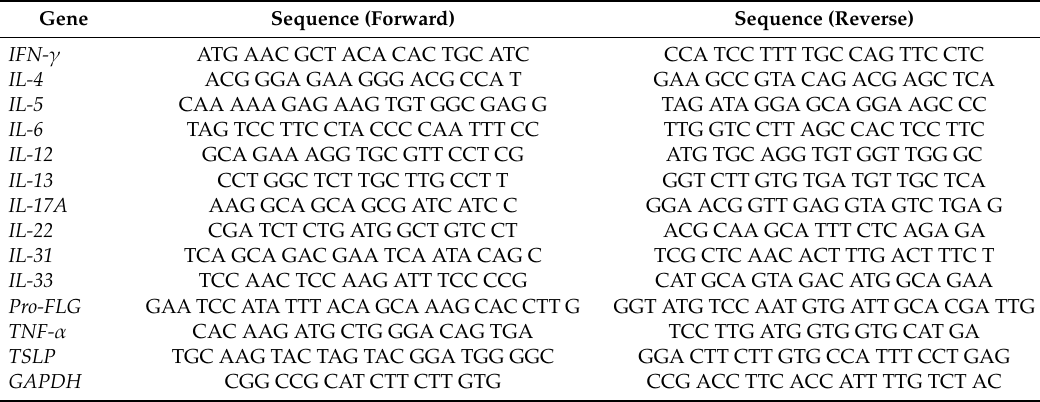
Table 1. The primer sequences (in